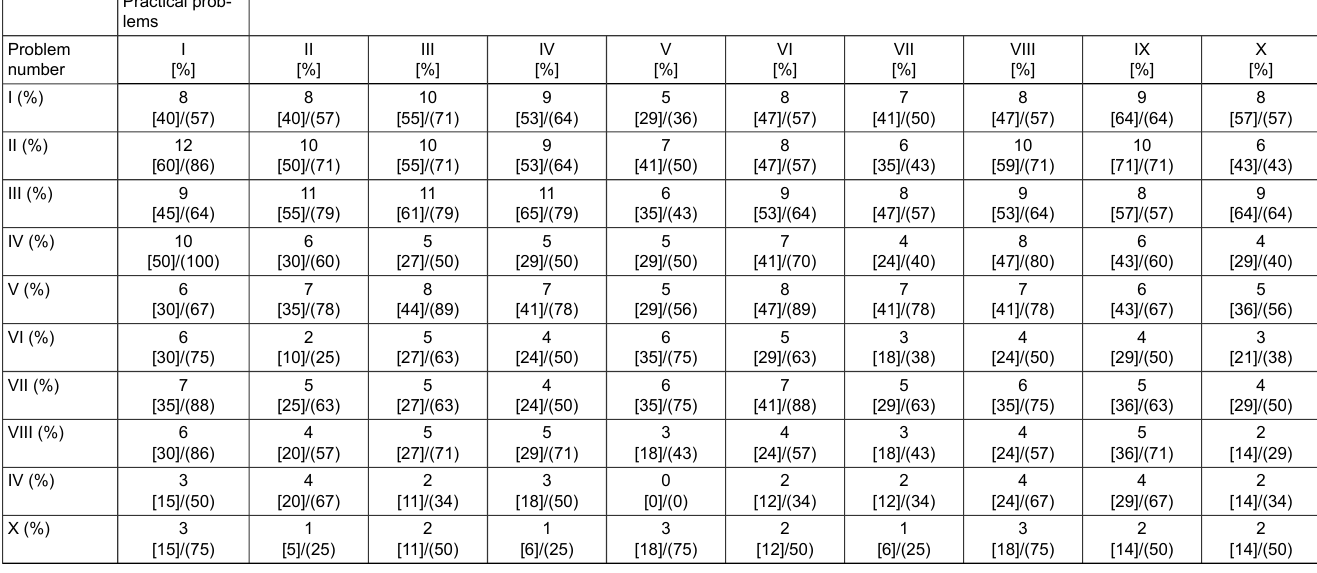
Table 3: The frequency of collocation between particular reported practical and psychological problems within one interview. Percentages are rounded off/down. Practical prob- lems Problem